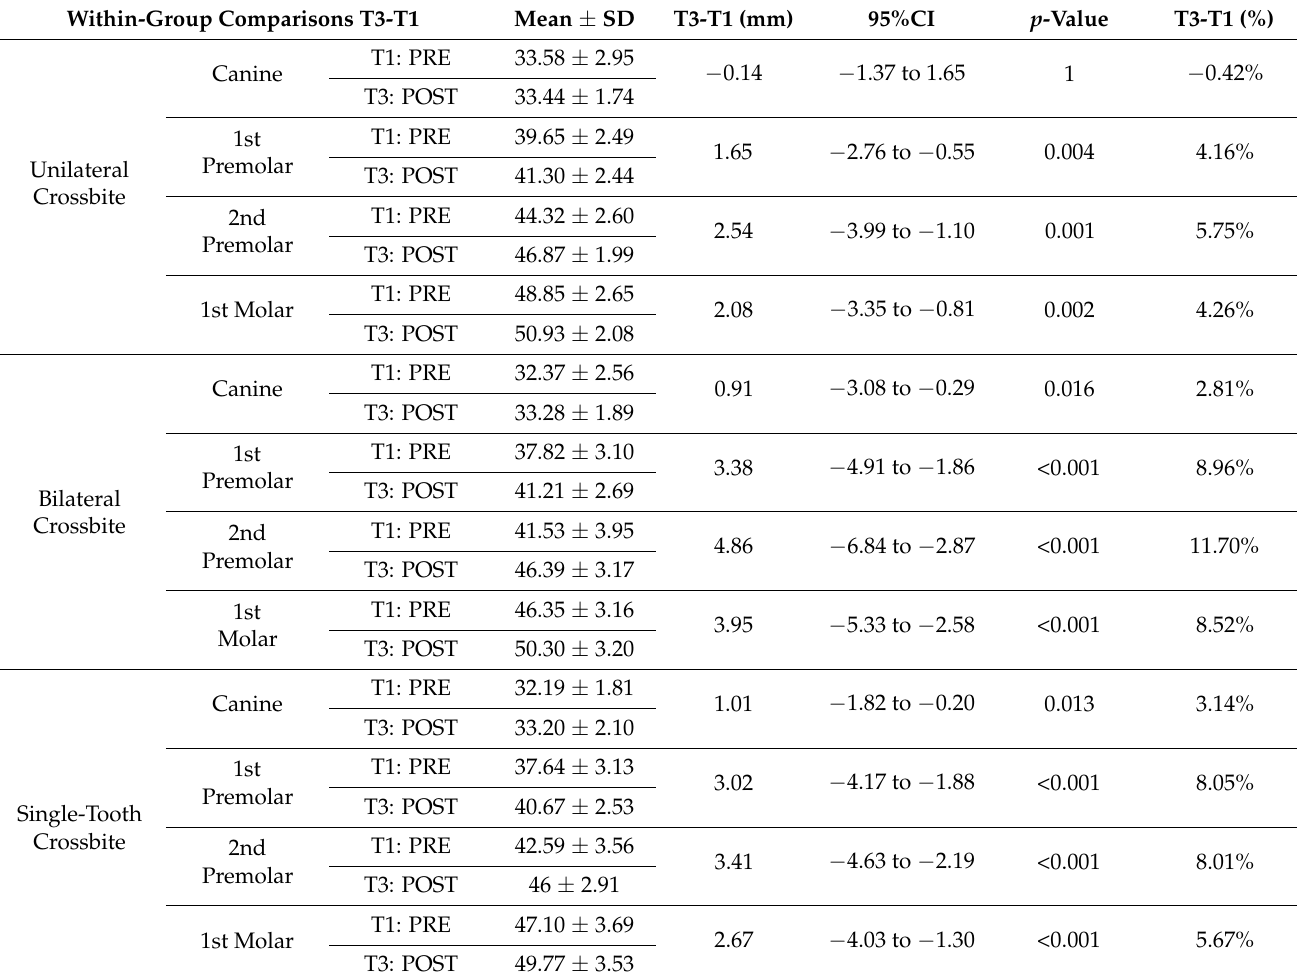
Table 2. Within-group comparisons of the efficacy (T3-T1) of expansion at canine, premolar, and molar levels. T1: pretreatment width; T3: post-treatment width; T3-T1(%): percentage of initial